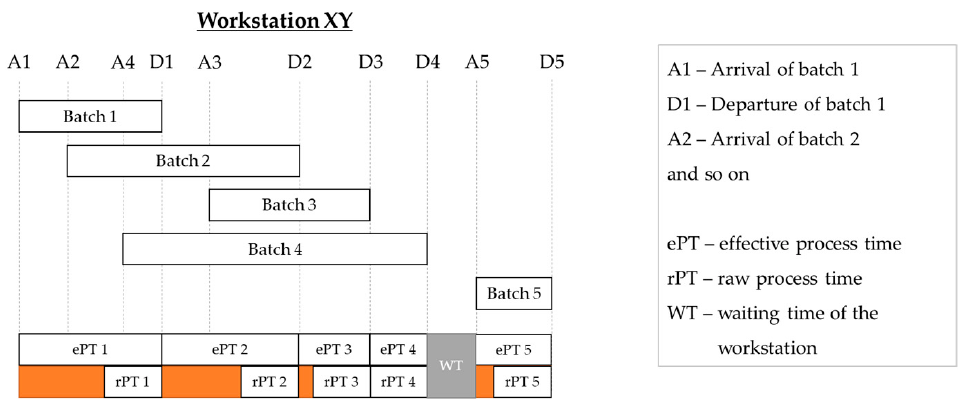
Figure 2. Capturing the effective process time of a workstation according to Jacobs, J. H. et al. [12]. After a certain time, several effective process times are determined, resulting in a complete distribution of the effective process time. For the production unit, the average effective process time and the associated coefficient of variation can be calculated to investi- gate the inherent temporal variability. Extracting the raw process time from the effective process time shows the non-value-adding part. Setup times and/or downtimes of the production unit affect the effective process time. Consequently, the causes for inherent temporal variability can be limited to a certain extent. Hence, it must be questioned whether there are possibilities for a more detailed representation. In dividing variability into that which is controllable and uncontrollable, the approach offers no